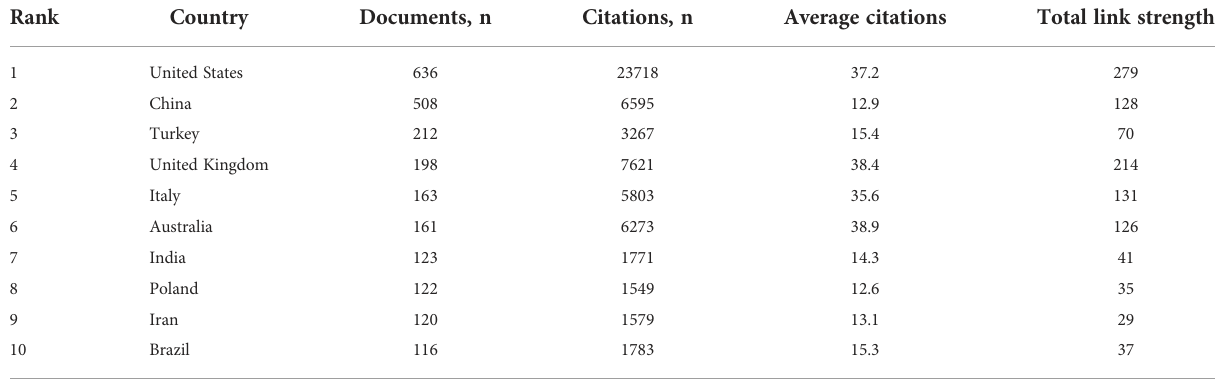
TABLE 1 Analysis of top 10 productive countries. Rank Country Documents, n